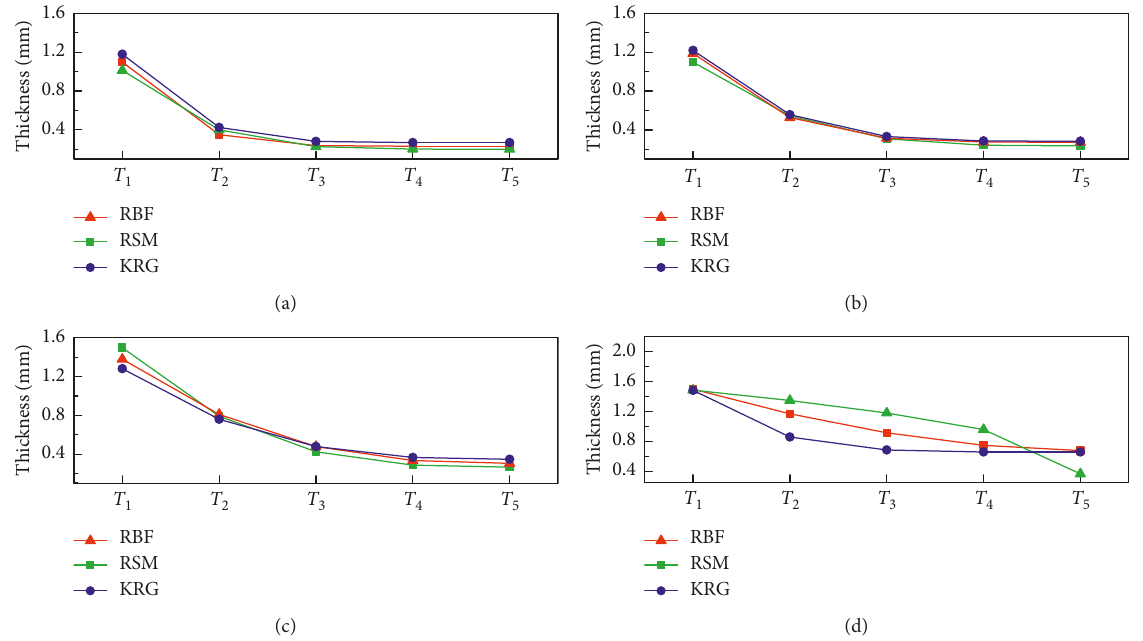
Figure 11: Various trends of optimal thickness under four cases by three surrogate models. (a) SEA SEA 22kJ/kg. (d) SEA (cid:31)